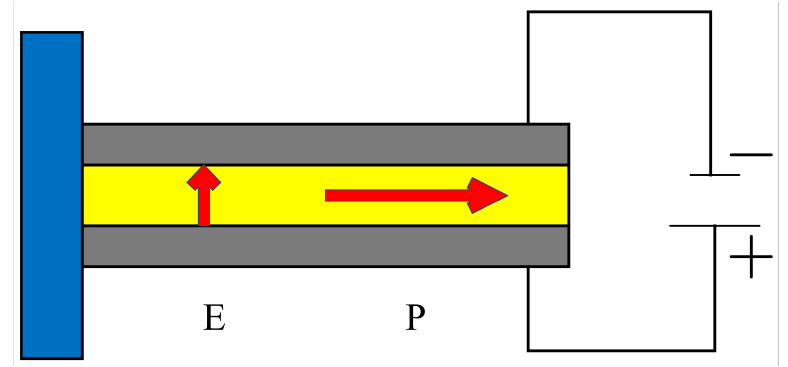
Figure 5. Shear mode energy